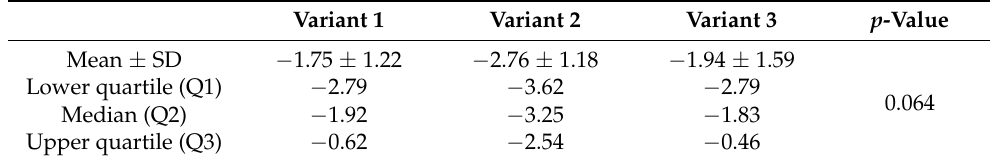
Table 7. The results of the analysis variance (ANOVA) of the influence of the washing variant on the resistance to surface